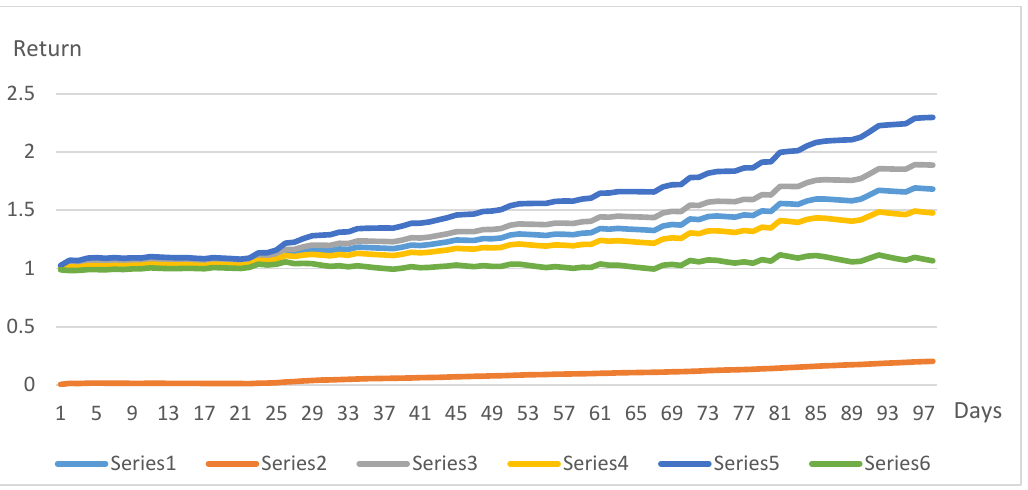
Figure 10. Confidence intervals of return on 3 stocks’ portfolio (German market) (source: compiled by the authors based on Yahoo Finance data and own calculations).